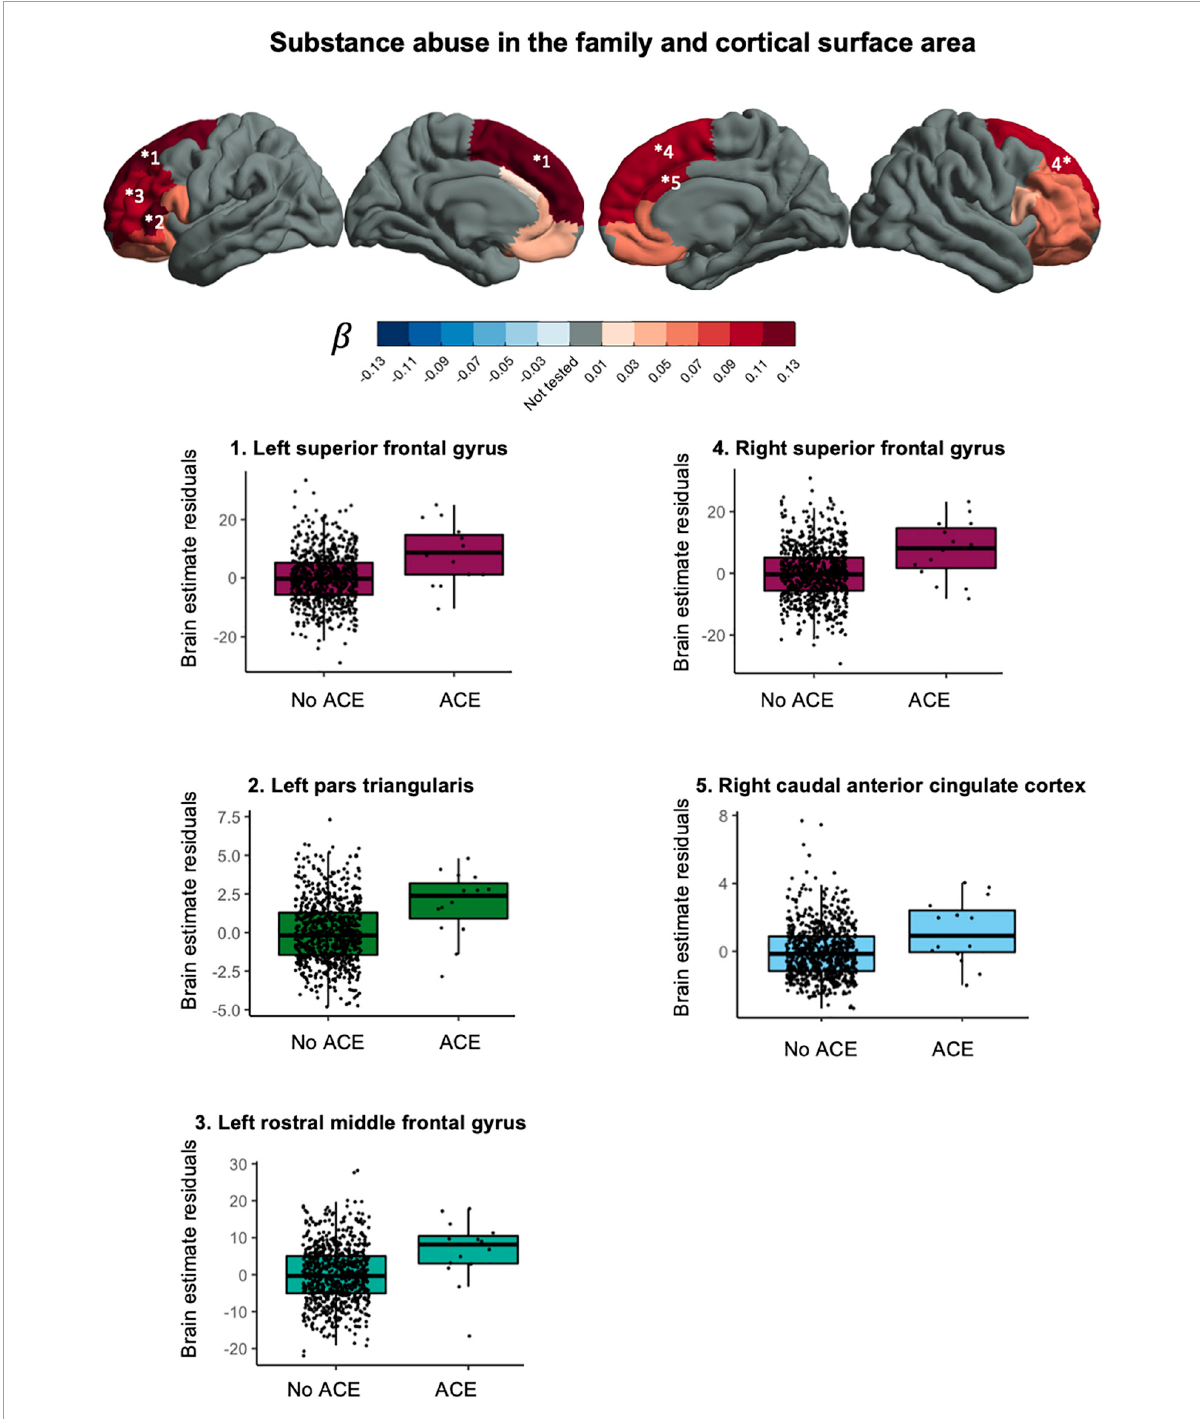
FIGURE4 Associations between substance abuse in the household and cortical surface area.